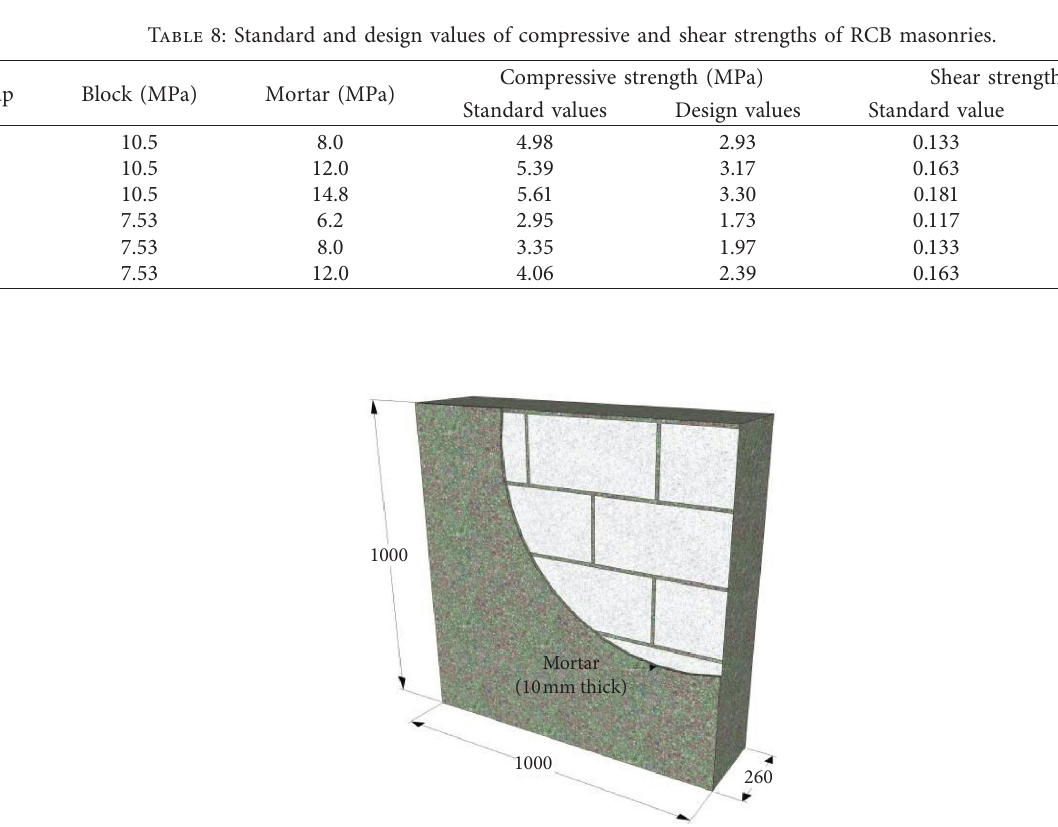
Figure 14: Size of RCB wall containing three rows of